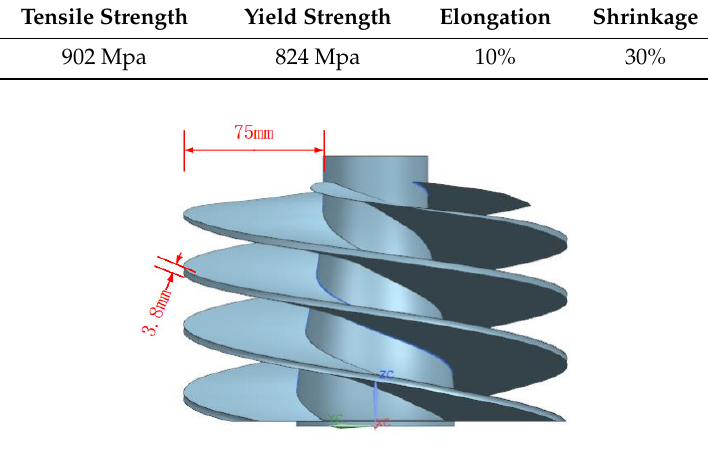
Figure 1. Workpiece model. Table 1. Chemical composition table of titanium alloys w (%).